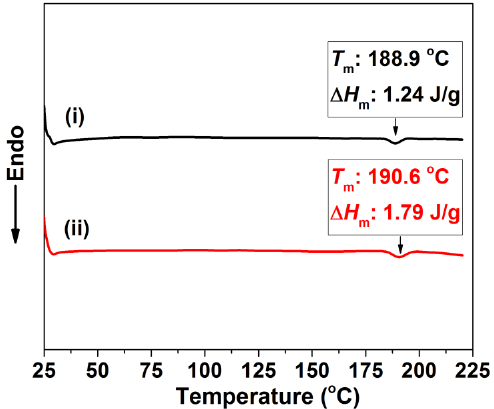
Figure 1. DSC thermogram of TPU specimens: ( i ) original TPU; ( ii ) TPU after saturating process.